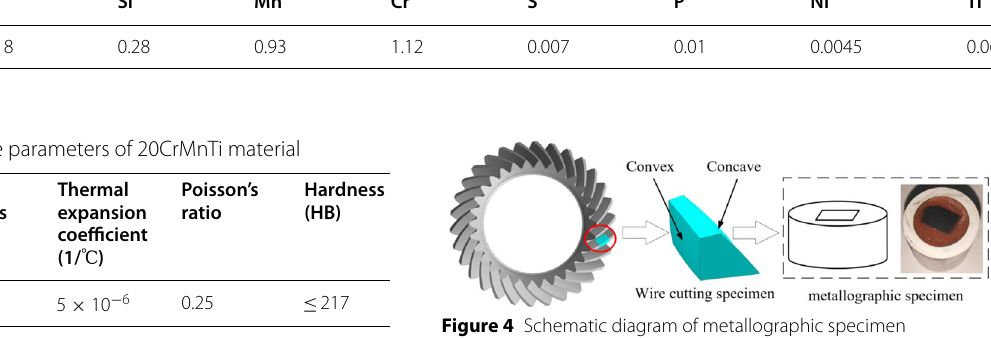
Table 1 Chemical composition of 20CrMnTi Element